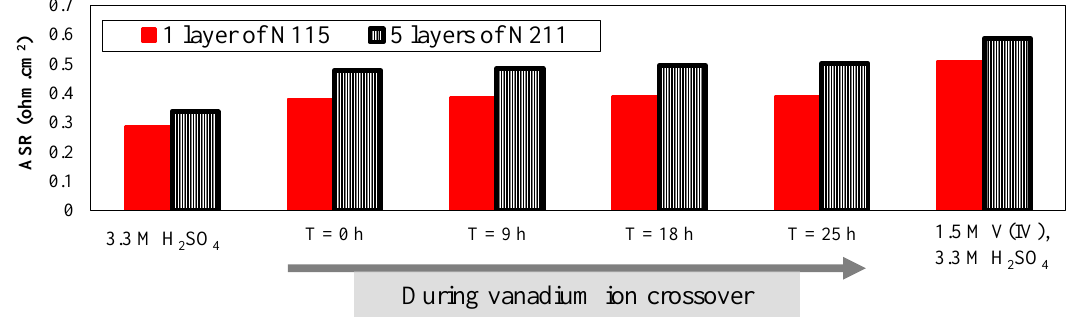
Figure 10. Comparison of ASR for multilayers of NR211 with a single layer N115 Nafion ® membrane during crossover measurement.